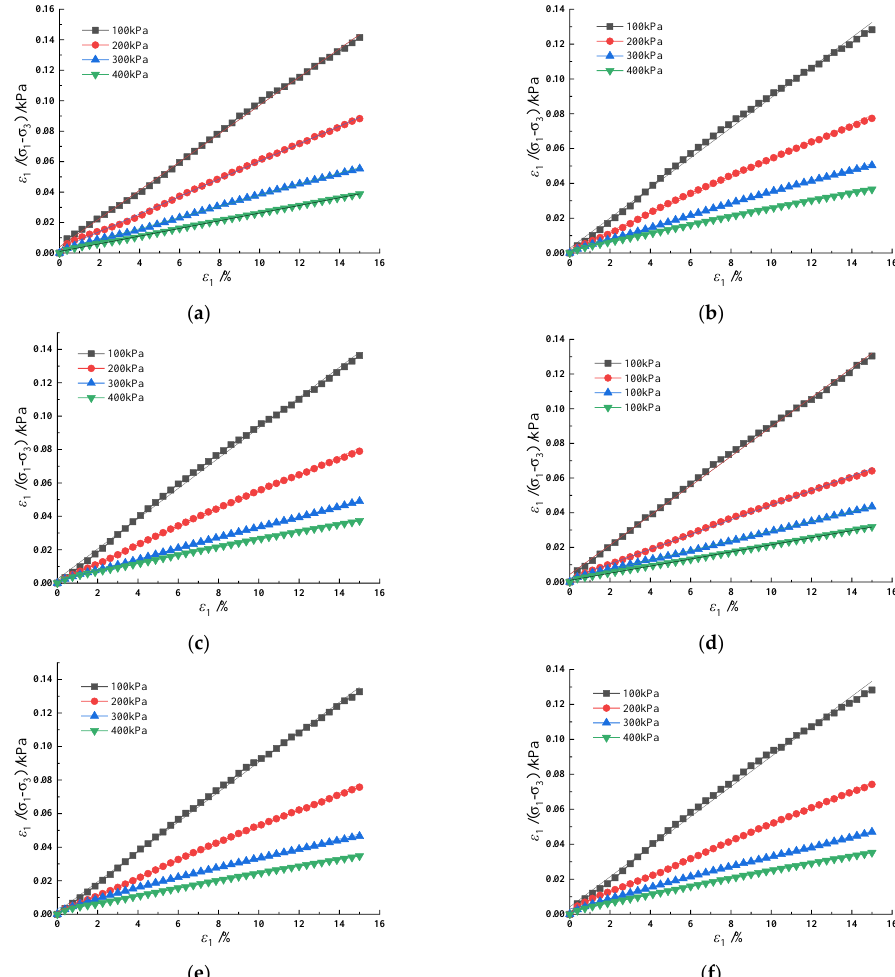
Figure 10. ε 1 / ( σ 1 – σ 3 ) ∼ ε 1 curve of sample. ( a ) 0% coir fiber; ( b ) 0.2% coir fiber; ( c ) 0.25% coir fiber; Figure 10. 11 / ~     13 （ - ） curve of sample. ( a ) 0% coir fiber; ( b ) 0.2% coir fiber; ( c ) 0.25% coir ( d ) 0.3% coir fiber; ( e ) 0.35% coir fiber; ( f ) 0.4% coir fiber; ( d ) 0.3% coir fiber; ( e ) 0.35% coir fiber; ( f ) 0.4% coir fiber.